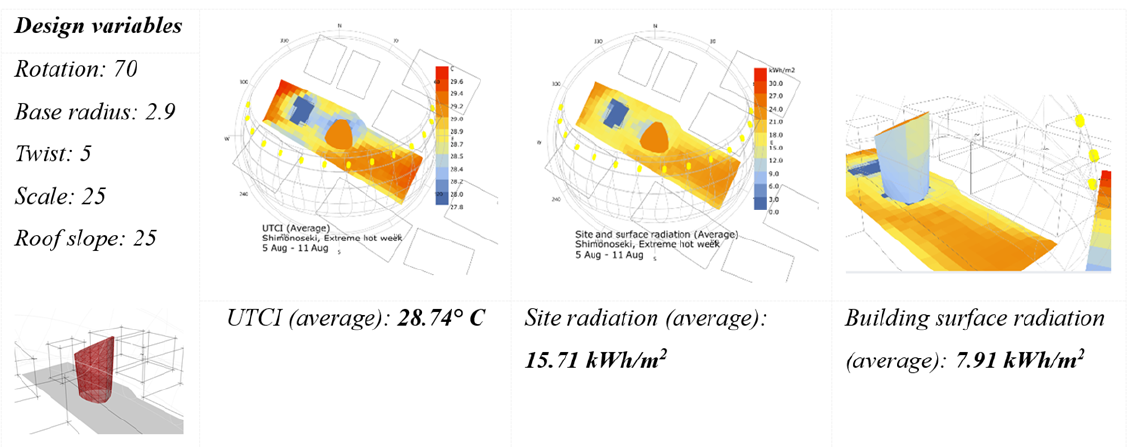
Fig. 7. Analysis results for minimum radiation